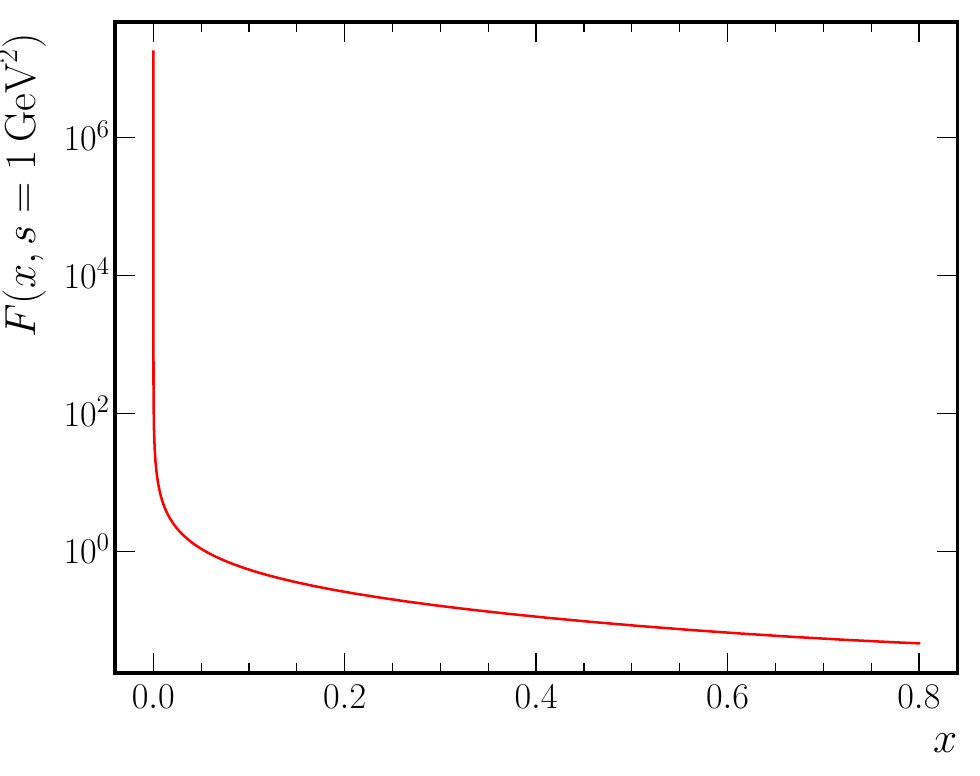
Figure 1. The dependence of kernel function F ( x, s ) on x at